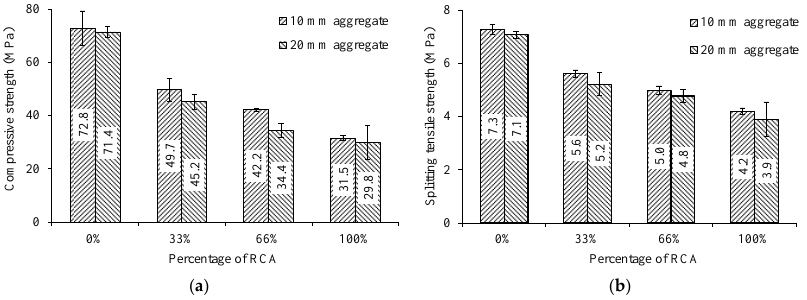
Figure 6. Effect of RCA replacement levels for two aggregate sizes on: ( a ) concrete compressive strength; and ( b ) splitting tensile strength.